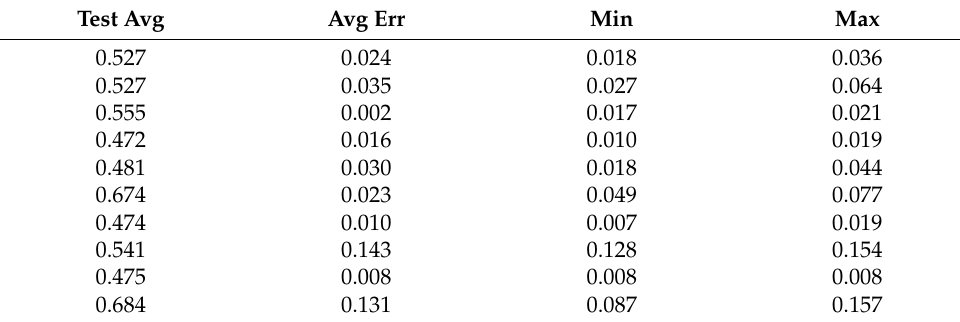
Table A54. Set 1, trials 31–40 data (average actual PR values).